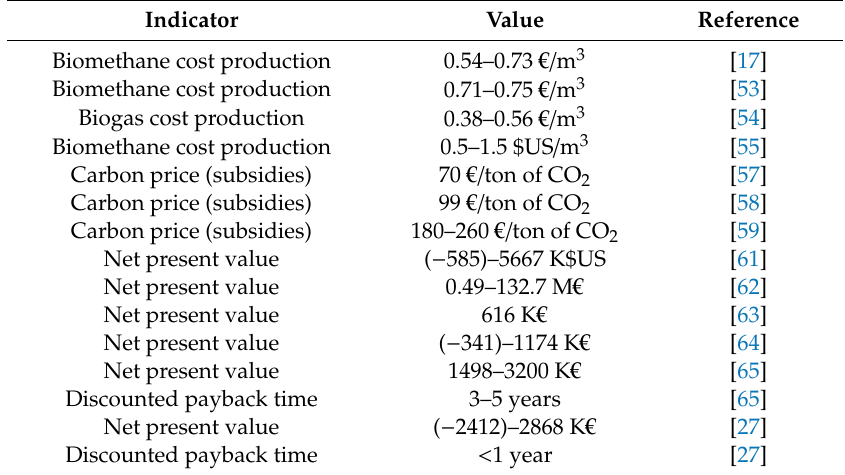
Table 1. Literature review—economic analysis of biomethane plants. USD—United States